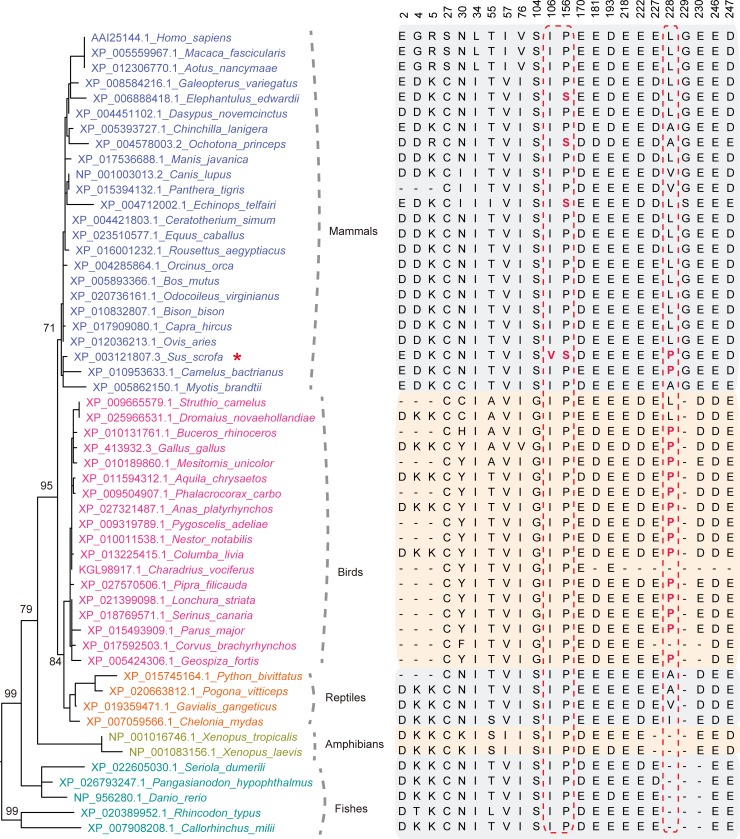
Phylogenetic analysis and amino acid sequence alignments of ANP32A proteins from different species.Bootstrap support values are indicated near the selected nodes. Right-hand columns display different amino acids in vertebrate ANP32A proteins.